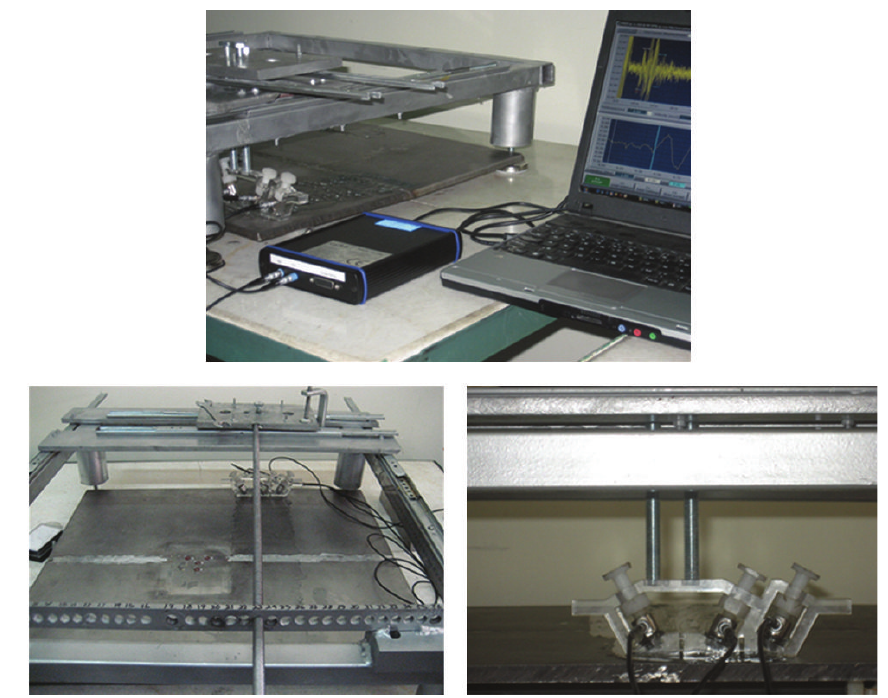
Figure 4: Measurement